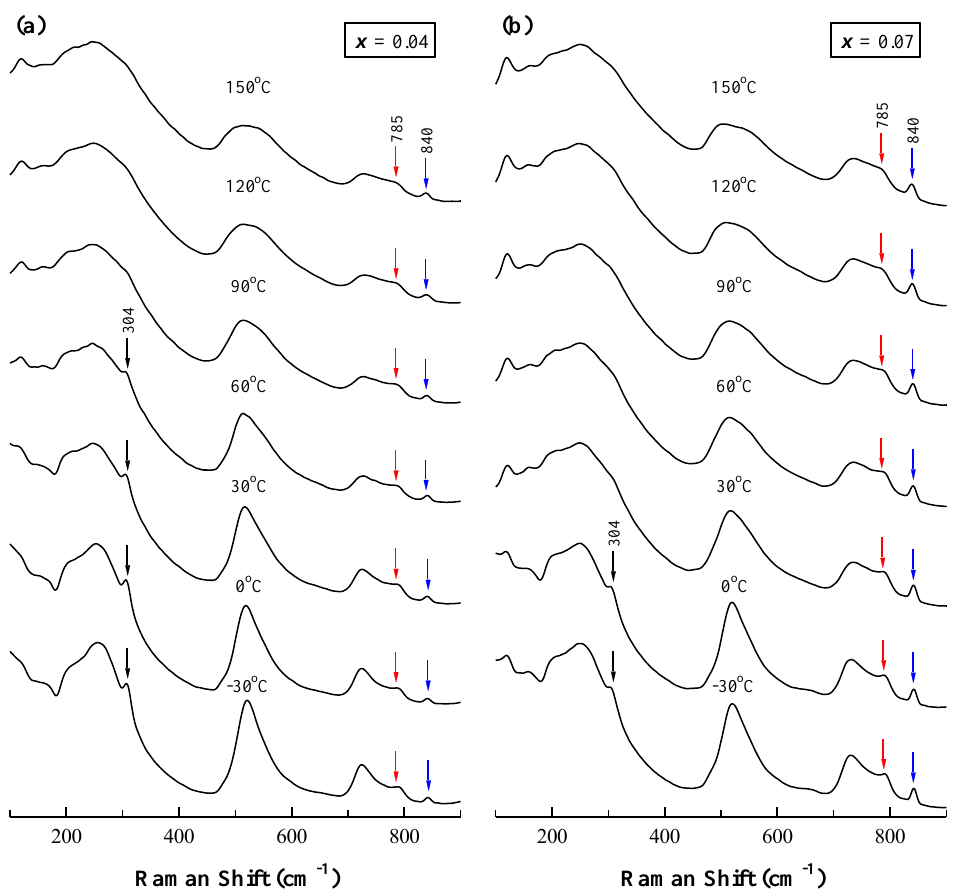
Figure 5. Temperature-dependent Raman spectra of samples with ( a ) x = 0.04 and ( b ) x = 0.07 excited by a 532 nm laser.